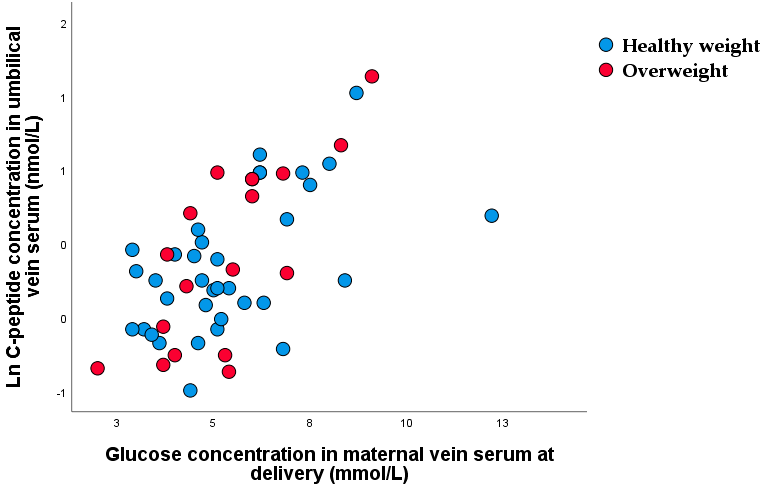
Figure 3. Scatter plot of nonparametric correlations between maternal venous glucose and umbilical vein C-peptide concentrations (r rho = 0.566, p < 0.001). Significant nonparametric correlations were found between umbilical vein serum glucose and C-peptide concentration (Figure 4). A higher ratio of umbilical vein glucose and C-peptide was found in healthy-weight 5.3 (4.2–7.2) than in overweight neonates 3.9